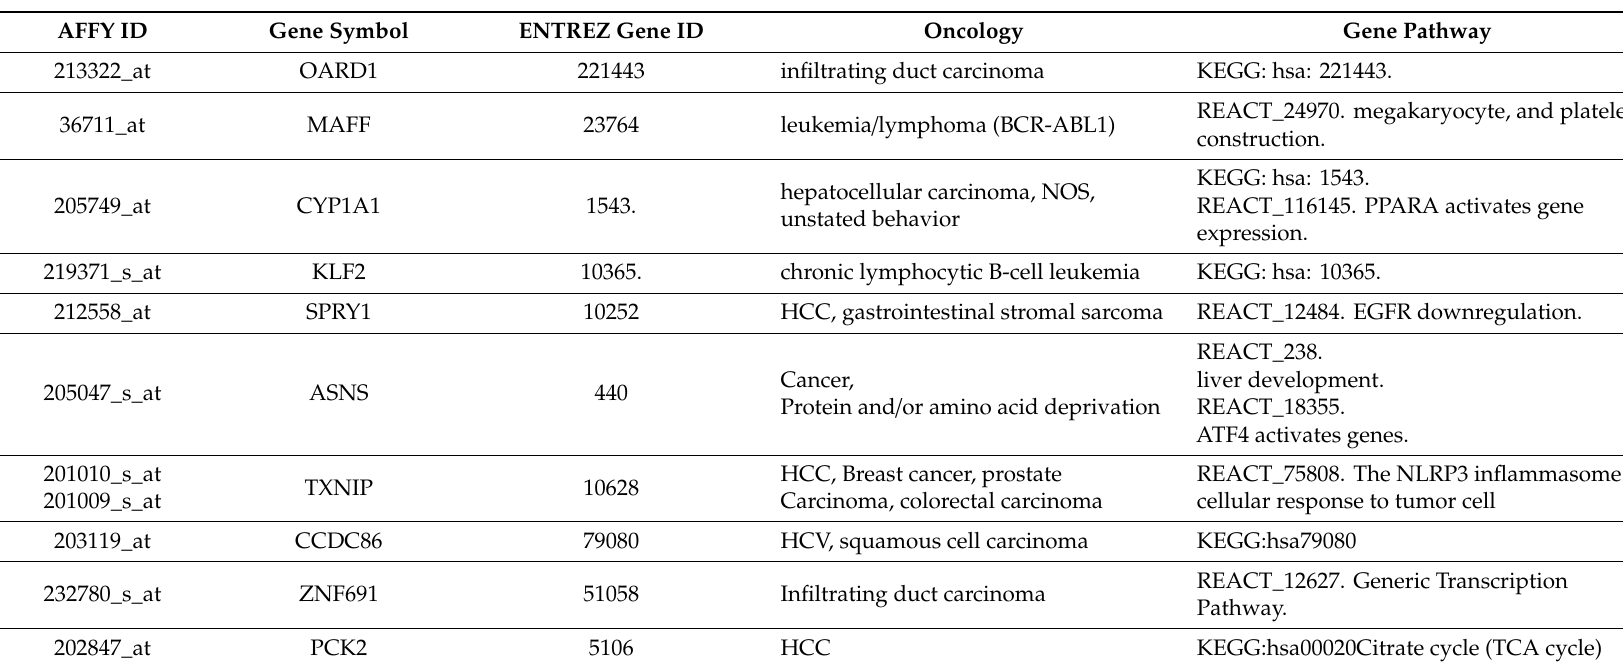
Table 2. Functional annotation of key genes detected using cosine coe ffi cient and Pearson’s correlation methods after di ff erent periods post-infection with C